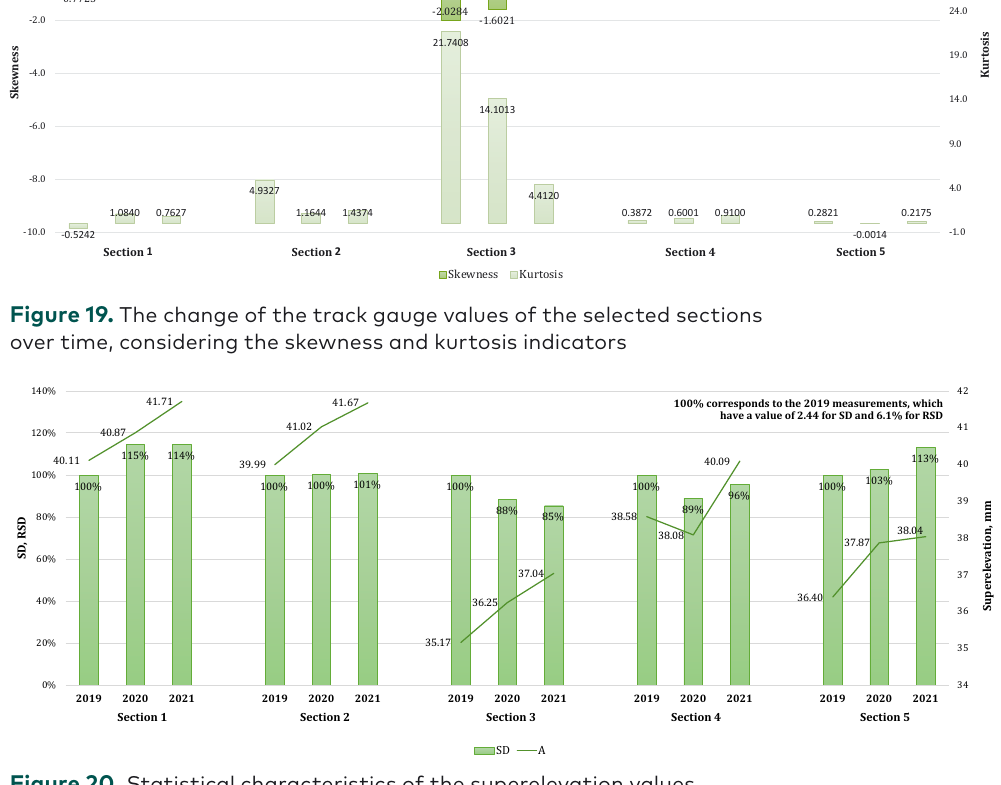
Figure 20. Statistical characteristics of the superelevation values of the selected